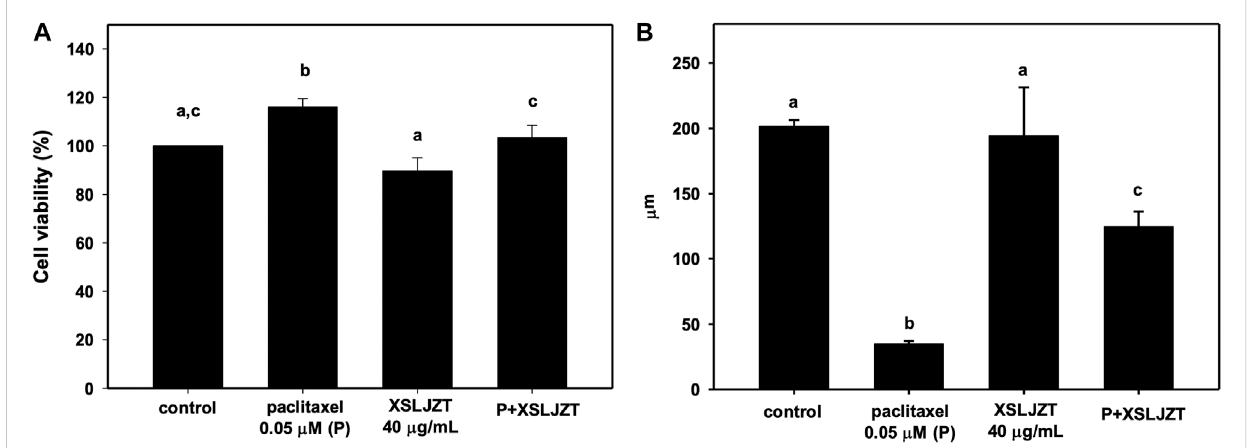
FIGURE 7 ThecellviabilityofDRGneuronstreatedwith0.05 μ MpaclitaxelwithorwithoutXSLJZTfor24 h (A) .TheneuritelengthofDRGneuronstreatedwith